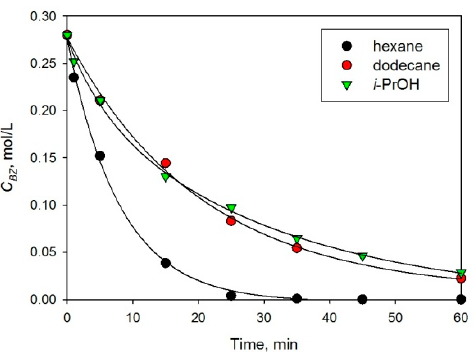
Figure 3. Solvent effect on BZ hydrogenation to CH over 2% Pt/HPS-NR 2 (230 °C , 5 MPa, C BZ ,0 = 0.28 mol/L, catalyst loading 100 mg).